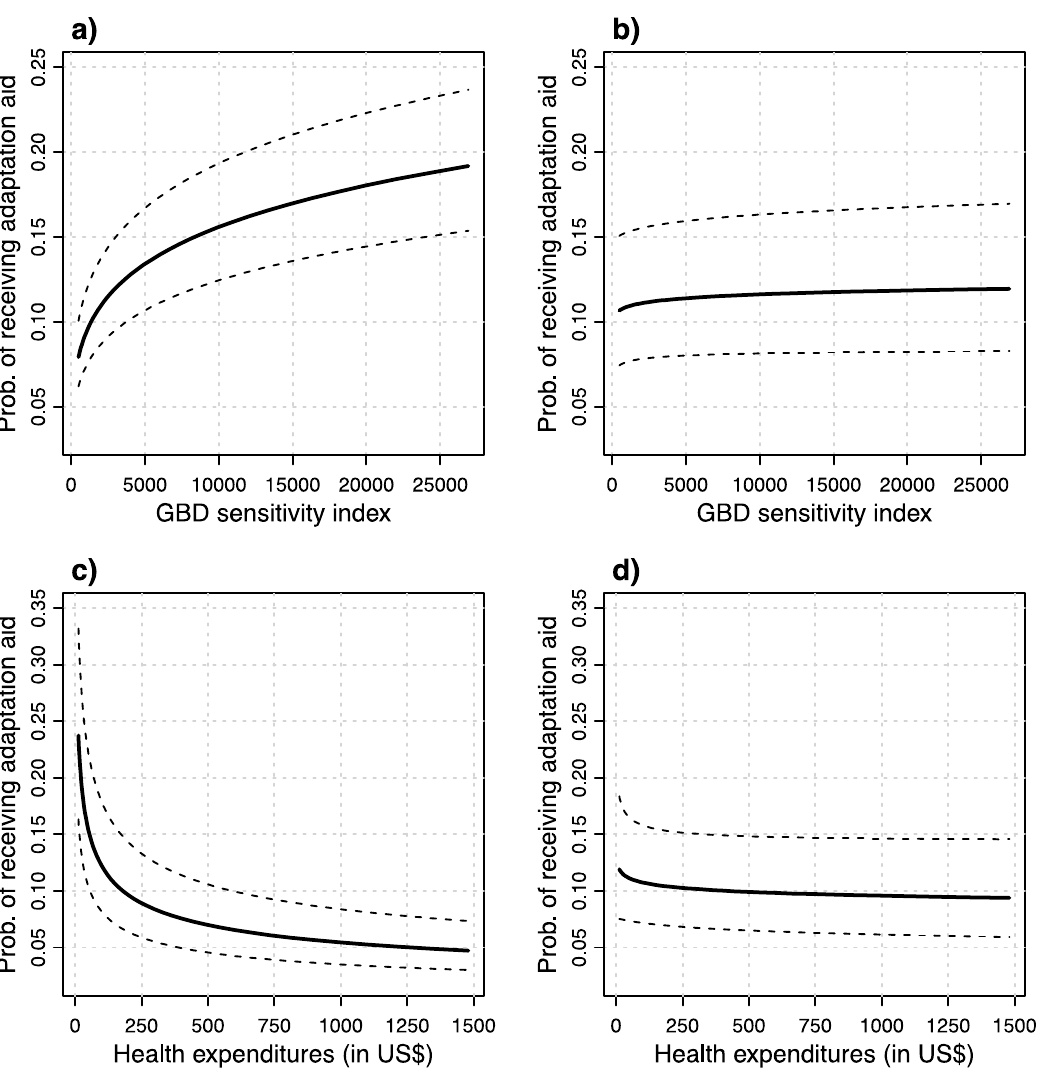
Figure 2. This figure shows the effects of health sensitivity to climate change on the likelihood of receiving adaptation aid. The figures in the panels ( a ) and ( b ) show the effect for the self-constructed Global Burden of Disease sensitivity index, without and with the GDP per capita control respectively. Panels ( c ) and ( d ) show the effect for health expenditures, again with and without the GDP control. The figures also show 90% confidence intervals.